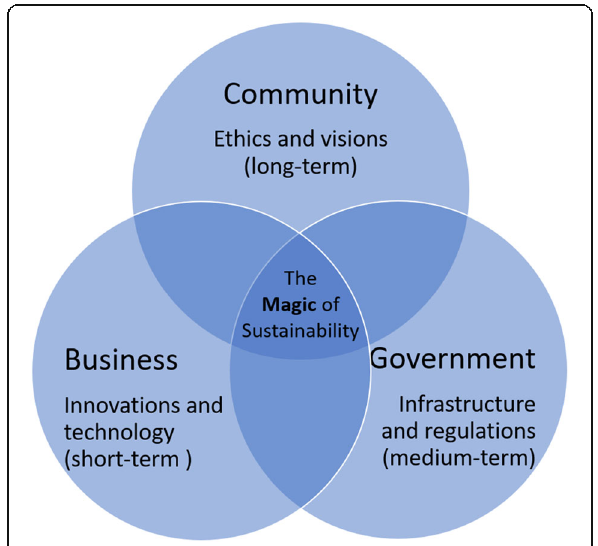
Fig. 3 The Magic of Sustainability (adapted from